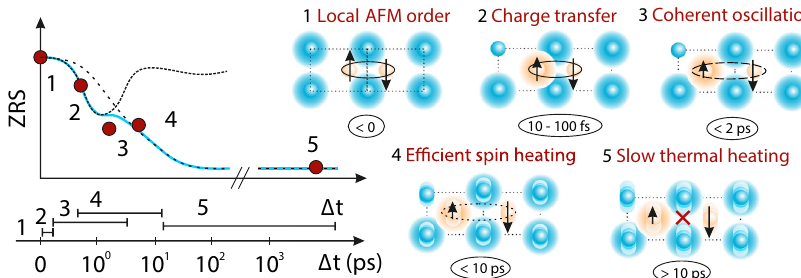
Fig. 5 Schematics of microscopic processes following photoexcitation. (Left) Approximate time scales for the different processes described (right). The pump pulse causes a charge transfer between O and Cu, which launches a short-range oscillation of a magneto-elastic mode, resulting in a modulation of the AFM coupling strength and correspondingly the ZRS intensity. Due to the heat transfer to the lattice, this mode is gradually removed, and therefore the lattice and magnetic temperatures